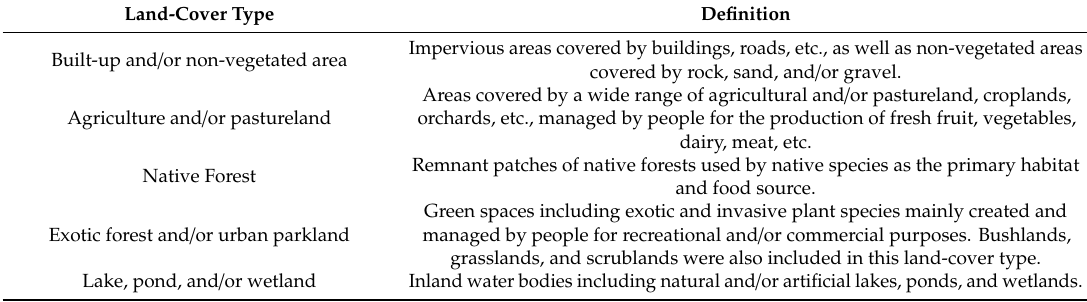
Table 4. Definitions of classified land-cover types in Curitiba and